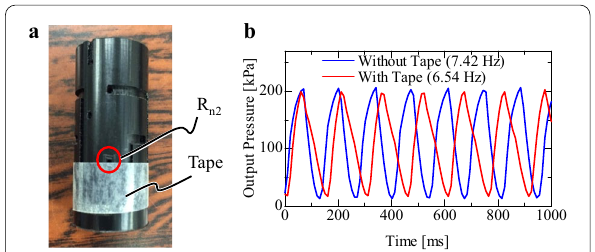
Fig. 20 Additional method to control the frequency. a Relief ports half closed by a tape. b Experimental